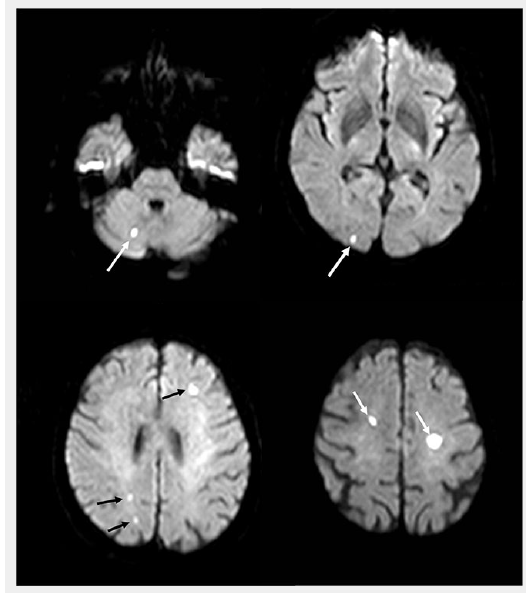
Figure 3 Silent bilateral cerebrovascular emboli after transcatheter aortic valve implantation. Such diffuse, bihemispheric ischaemic lesions can be detected by MRT in 68–77% of patients after TAVI.